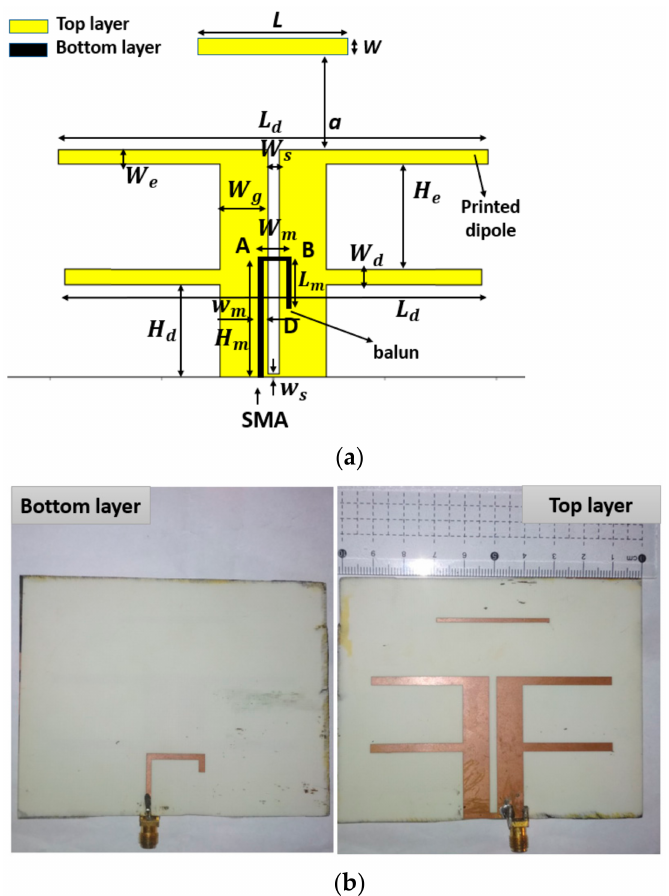
Figure 1. ( a ) The antenna element structure; ( b ) the antenna prototype.